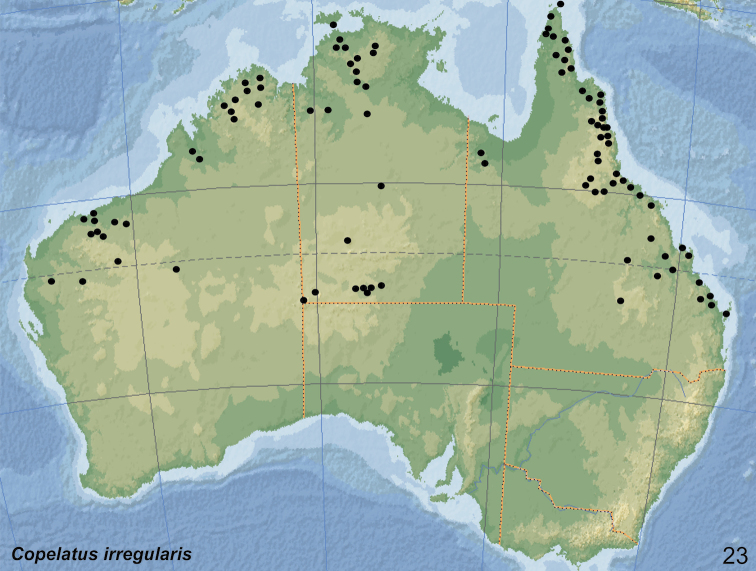
Distribution of Copelatus
irregularis.